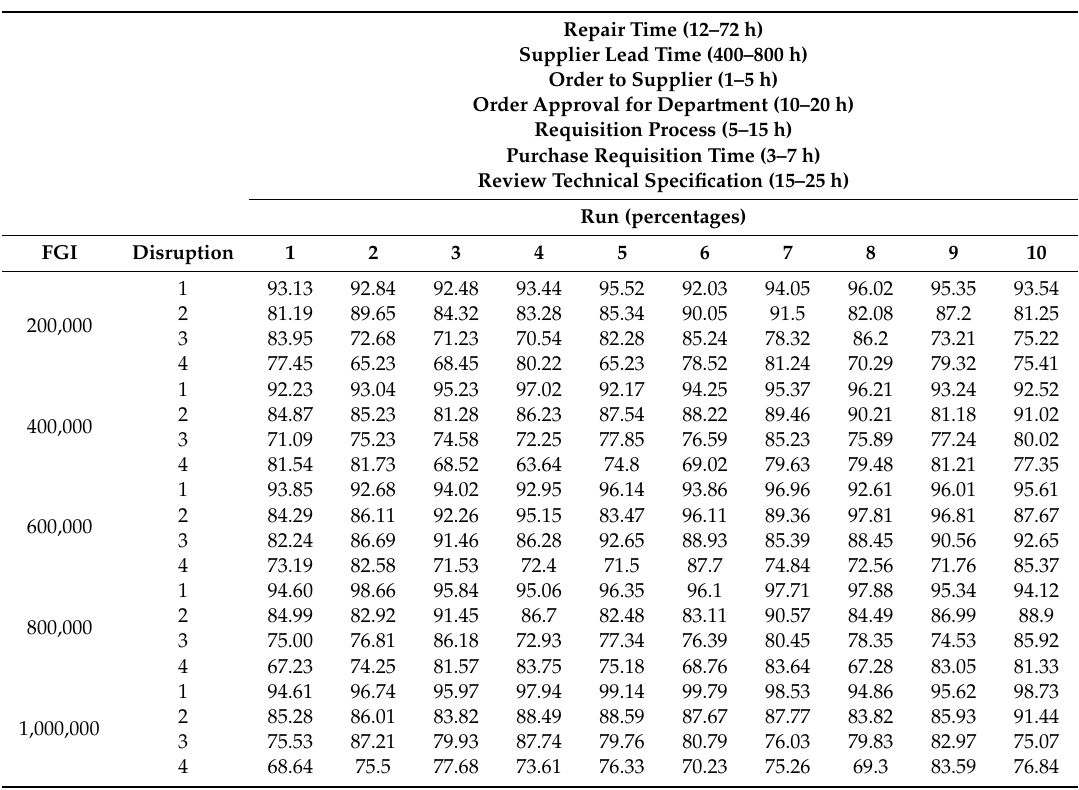
Table 3. Results for 200